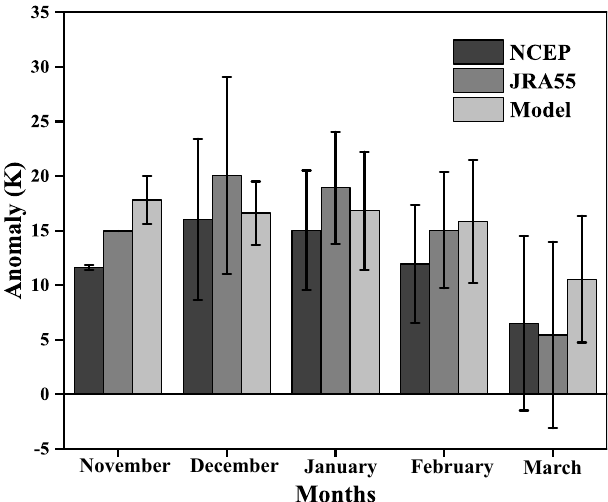
Figure 3. Composite of mean area-weighted polar cap (60° – 90° N) temperature anomaly at 10 h Pa, ± 5 days from the SSW onset date in each wintertime month for the NCEP / NCAR ( black ) and JRA55 reanalyses ( dark grey ) and CESM1-WACCM ( light grey ). The error bar denotes the inter-case standard deviation.